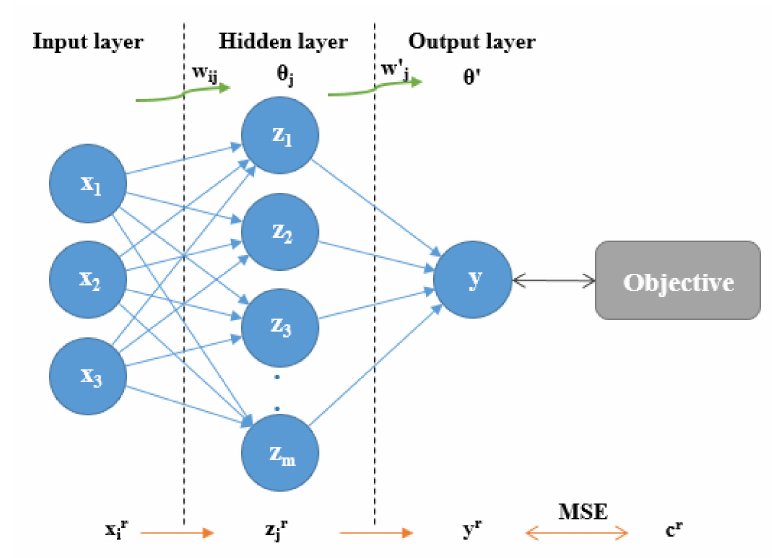
Figure 1. A scheme of the topological structure of the Multi-Layer Perceptron method.